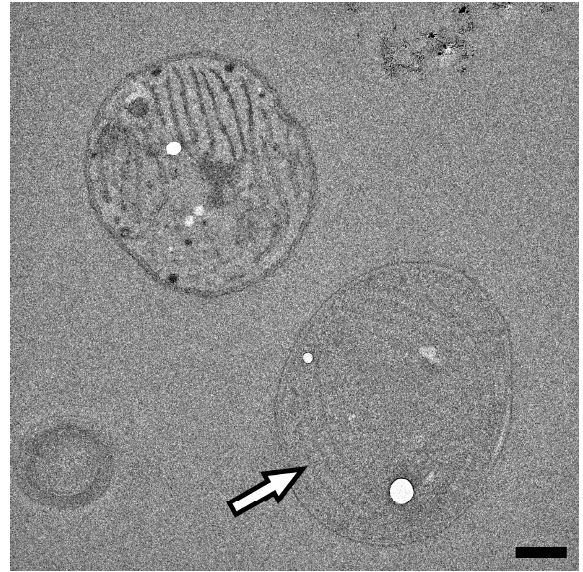
Figure 3. TEM image of unstained cyanobacterial cells obtained using a 200 kV electron beam. Thylakoid membranes marked by arrow. Scale bar: 500 nm.